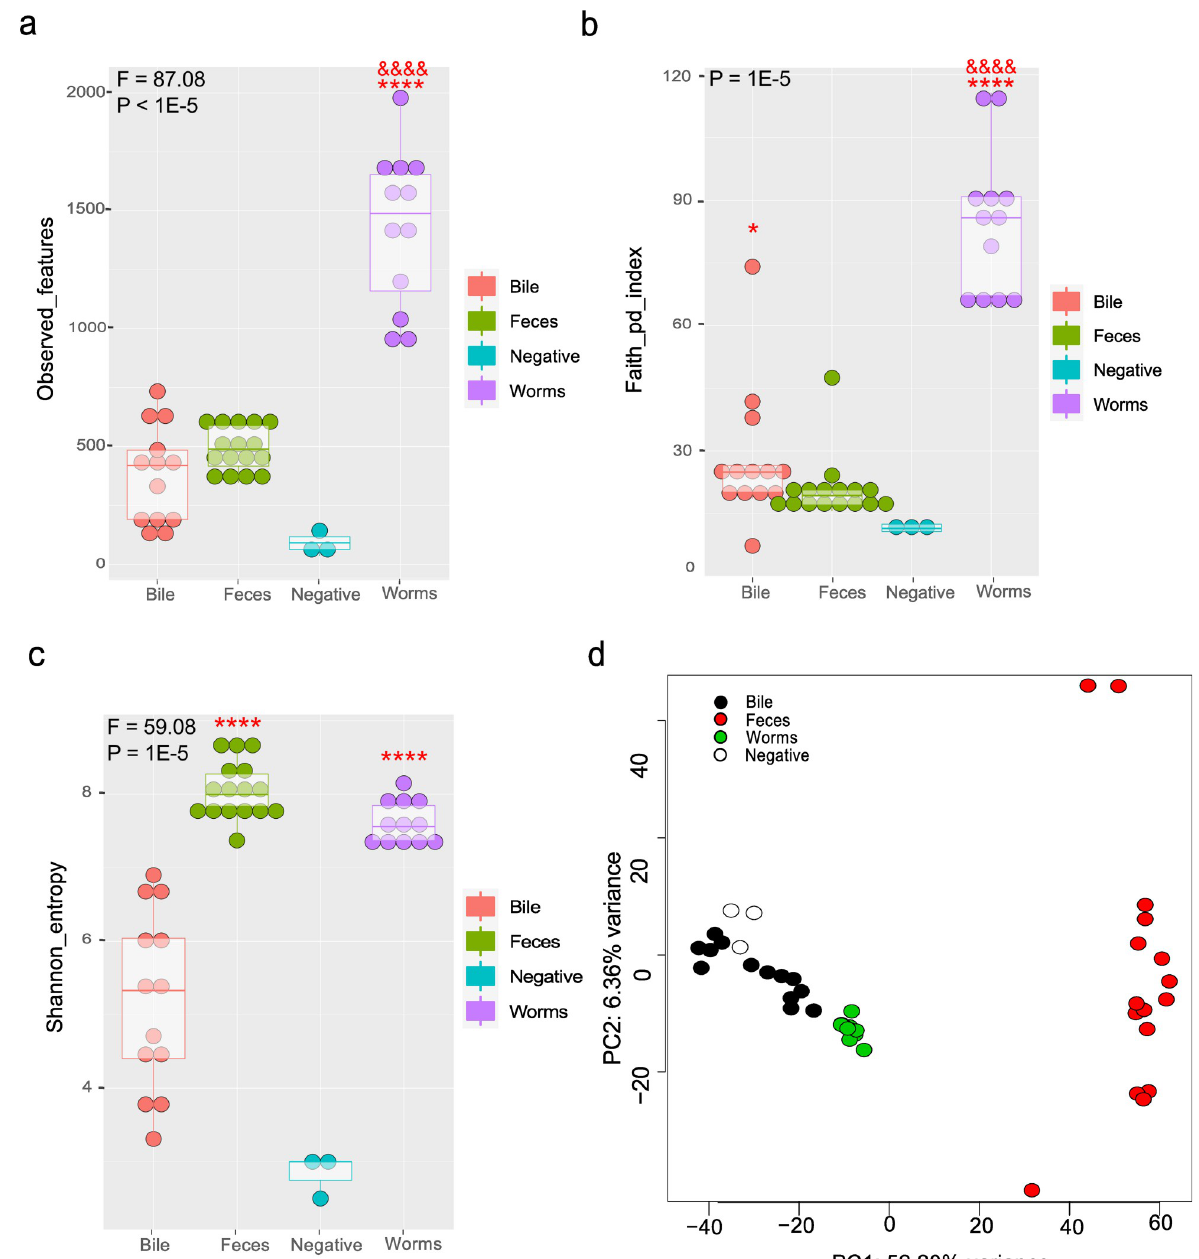
Fig 1. Alpha and beta diversity levels of the DNA libraries prepared from feces, bile, and worms. a. Observed features. b. Phylogenetic diversity index (Faith’s PD). c. Shannon’s index. d. Principal coordinates (Bray–Curtis distances) of DNA libraries. � P adj < 0.05 as compared to fecal samples, &&&& P ���� P adj < 0.001 as compared to bile samples, adj < 0.001 as compared to bile samples.